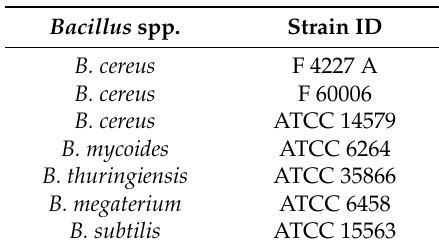
Table 2. Bacillus spp. used in this